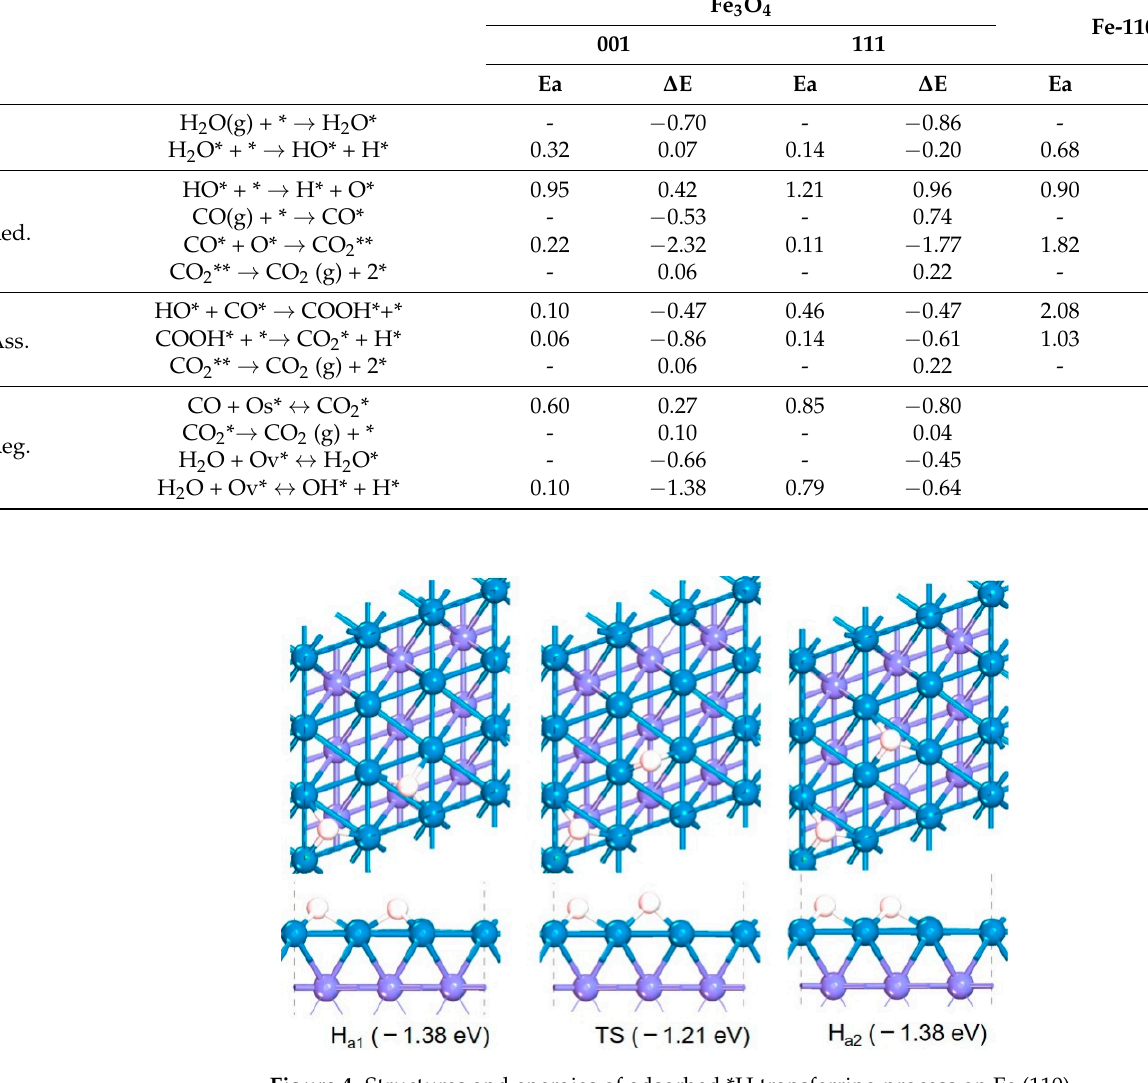
Figure 4. Structures and energies of adsorbed *H transferring process on Fe (110). After calculating the migration capacity of H, the generation capacity of H 2 on Fe (110) was also studied. Here, the most favorable H 2 generation path on Fe (110), that is, the reaction process of H 2 generation from two adjacent H atoms adsorbed on the surface, was calculated as shown in Figure 5. The H atom adsorbed from one Fe hole site migrates and attacks another *H adjacent to itself to generate adsorbed H 2 , which needs to overcome an energy barrier of 1.47 eV, and the reaction is endothermic with 1.43 eV. Therefore, when H and H 2 interact with Fe (110), it is more favorable to H 2 dissociation both thermally and dynamically. However, when the concentration of H on the surface is relatively high, it is also occurs for H 2